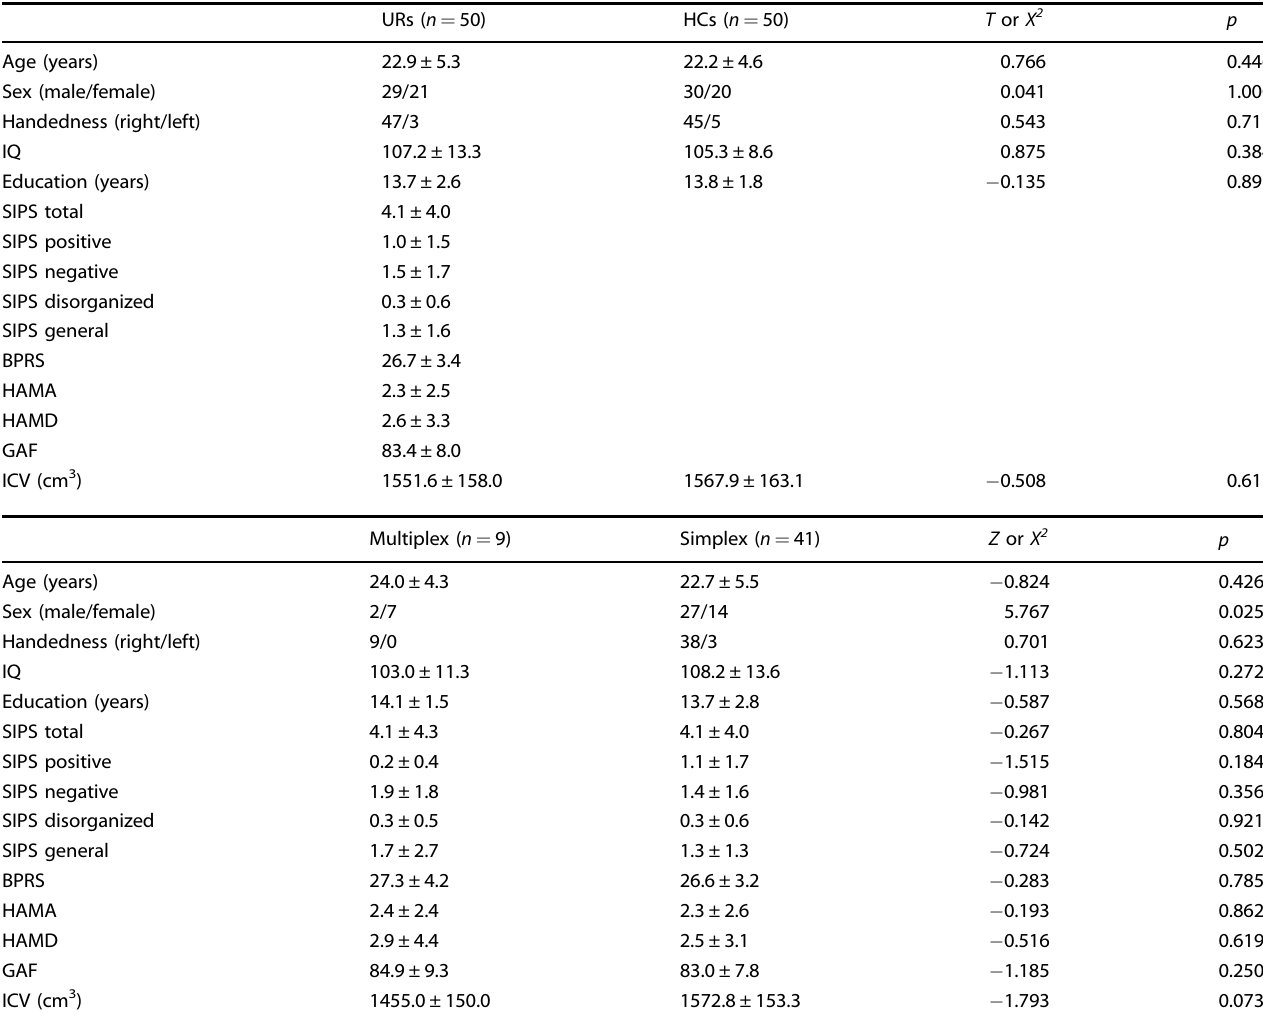
Table 2. Demographic information and clinical variables of the